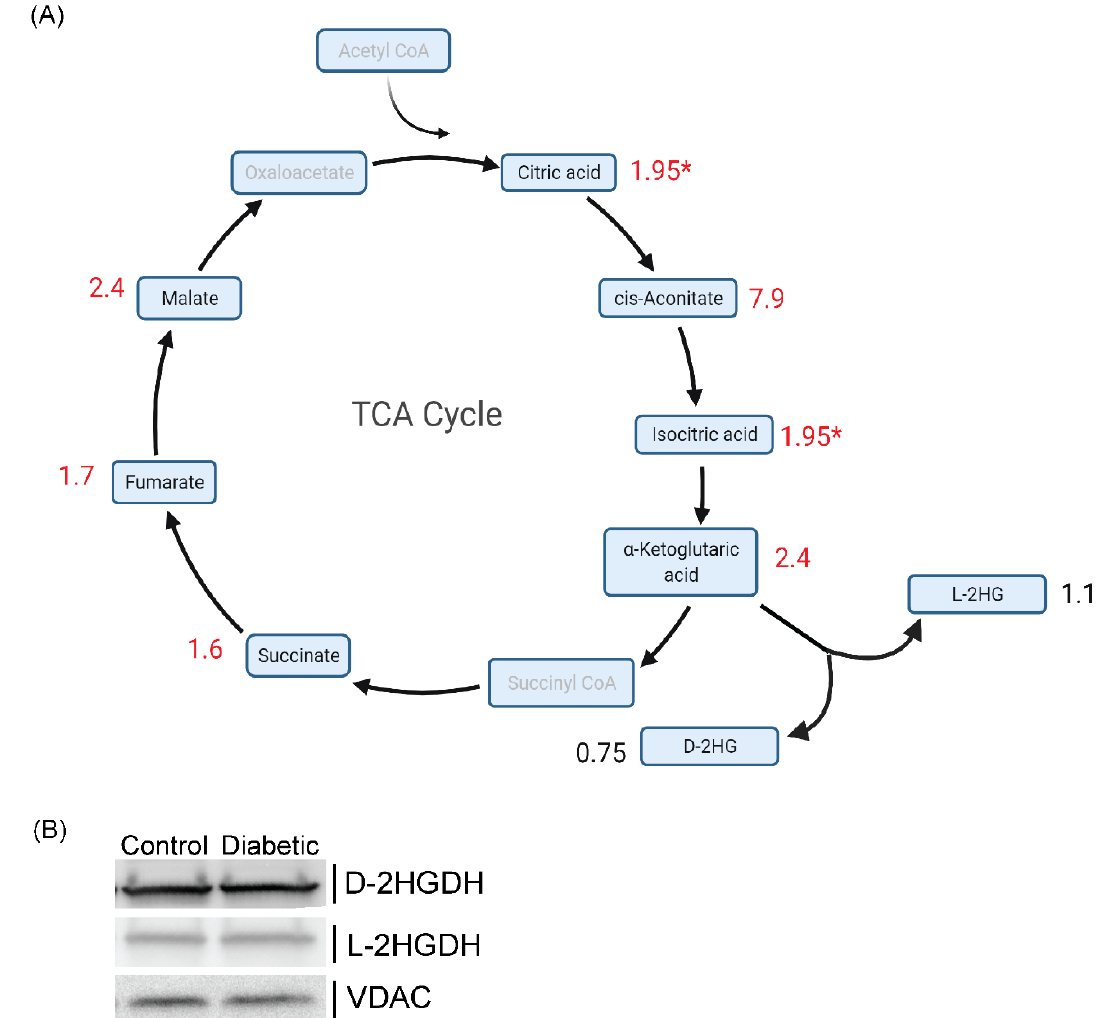
Figure 2. Kidney cortex levels of TCA cycle metabolites drive D and L-2HG production. ( A ) Schematic of TCA cycle with fold change (Control db / + vs. diabetic db / db ) denoted (red if p ≤ 0.05 and black if did not meet significance). Metabolites in gray were not measured in the study. *: Citrate and isocitrate were measured as one transition. ( B ) Western blot of db / + and db / db cortex for D-2HGDH, L-2HGDH, and VDAC ( n = 4). Figure 2A was created with